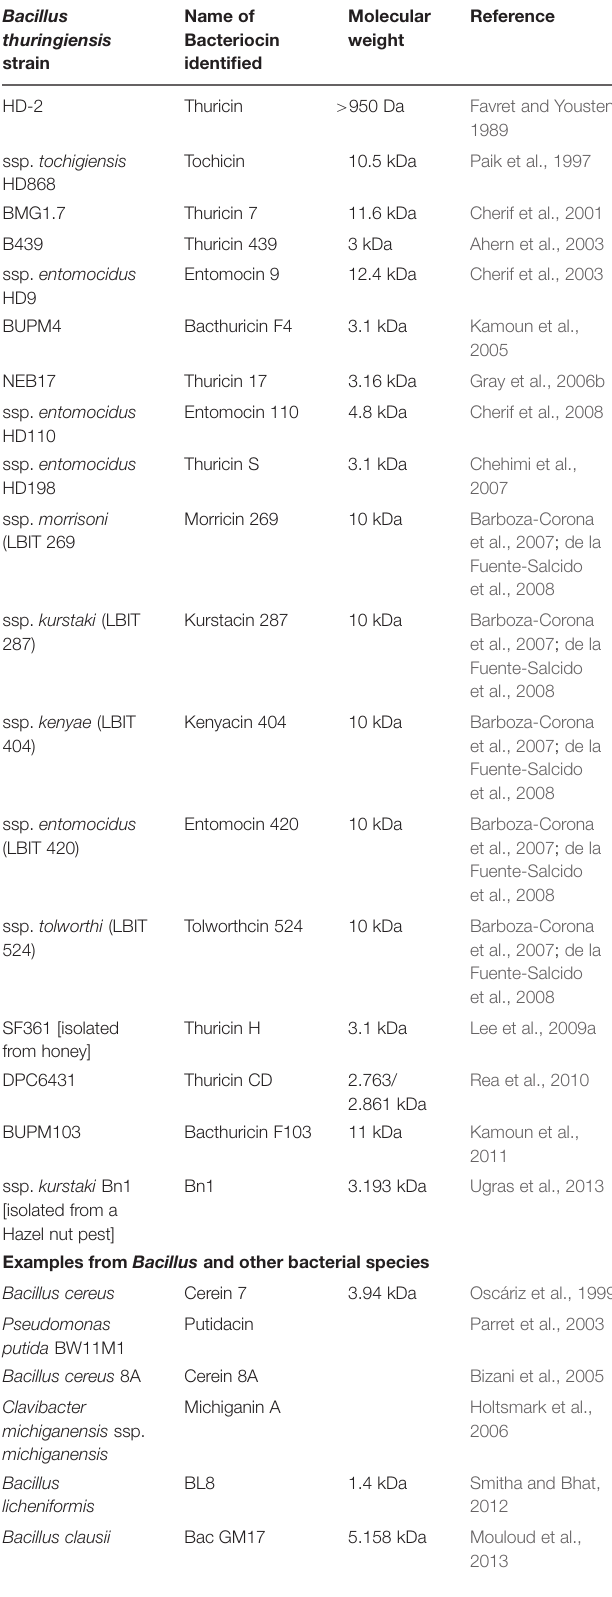
TABLE 1 | Bacteriocins identified from Bacillus thuringiensis and examples of other bacteriocin producers. Bacillus